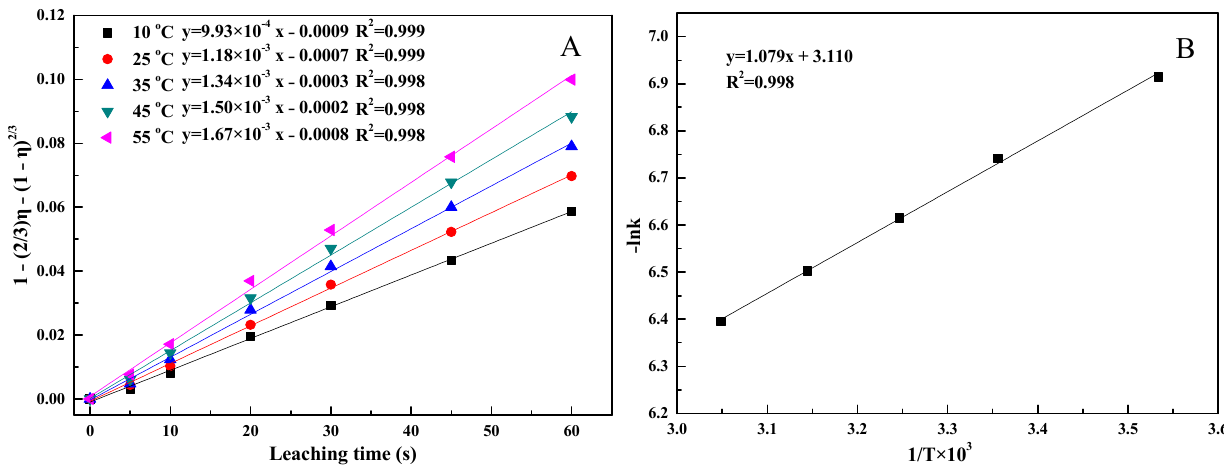
Figure 6. Leaching kinetic analysis of calcium at different temperatures. ( A ) plots of 1 − (2/3) η − (1 − η ) 2/3 vs. time; ( B ) Arrhenius plot.